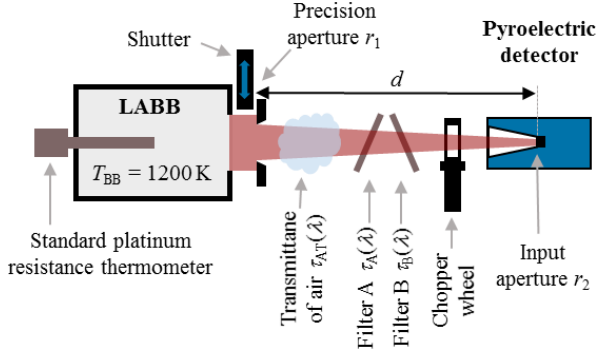
Figure 1. Measurement set-up for the calibration of the spectral responsivity of a pyroelectric detector at the large-area blackbody (LABB) with a precision aperture, two optical filters and a chopper